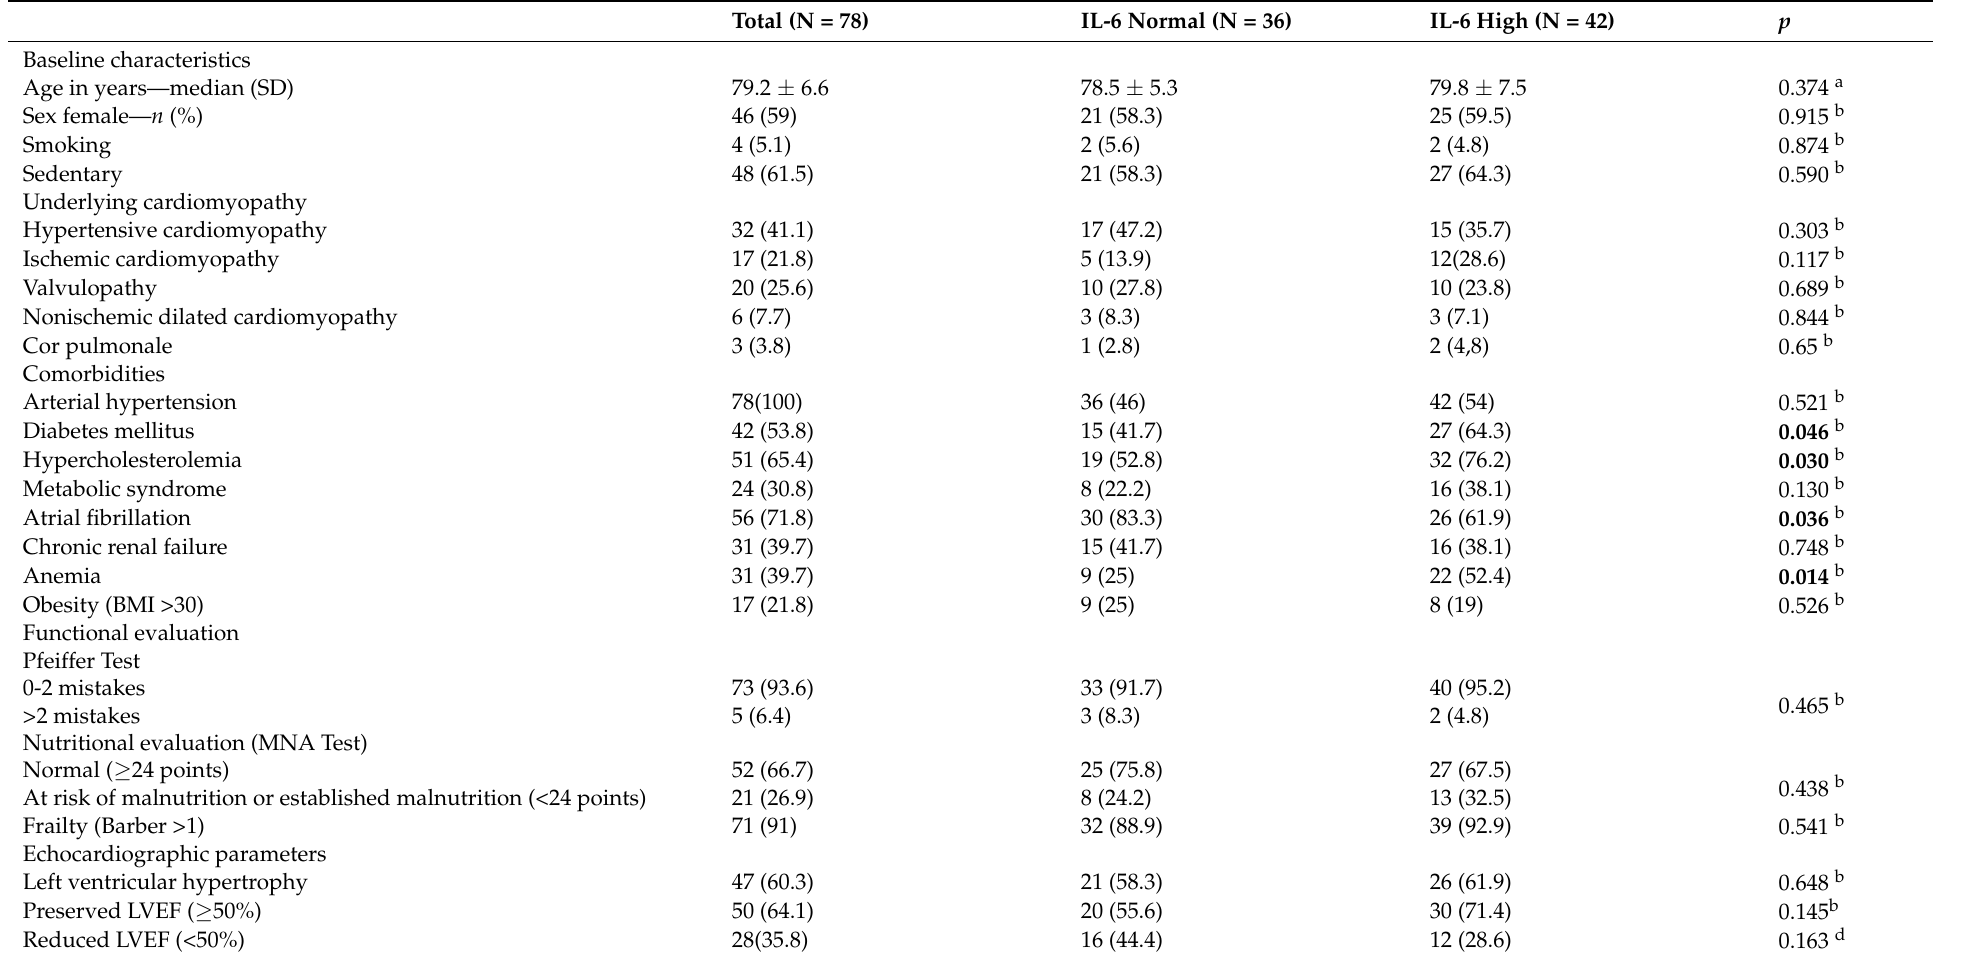
Table 1. Characteristics of the study population and comparison between both